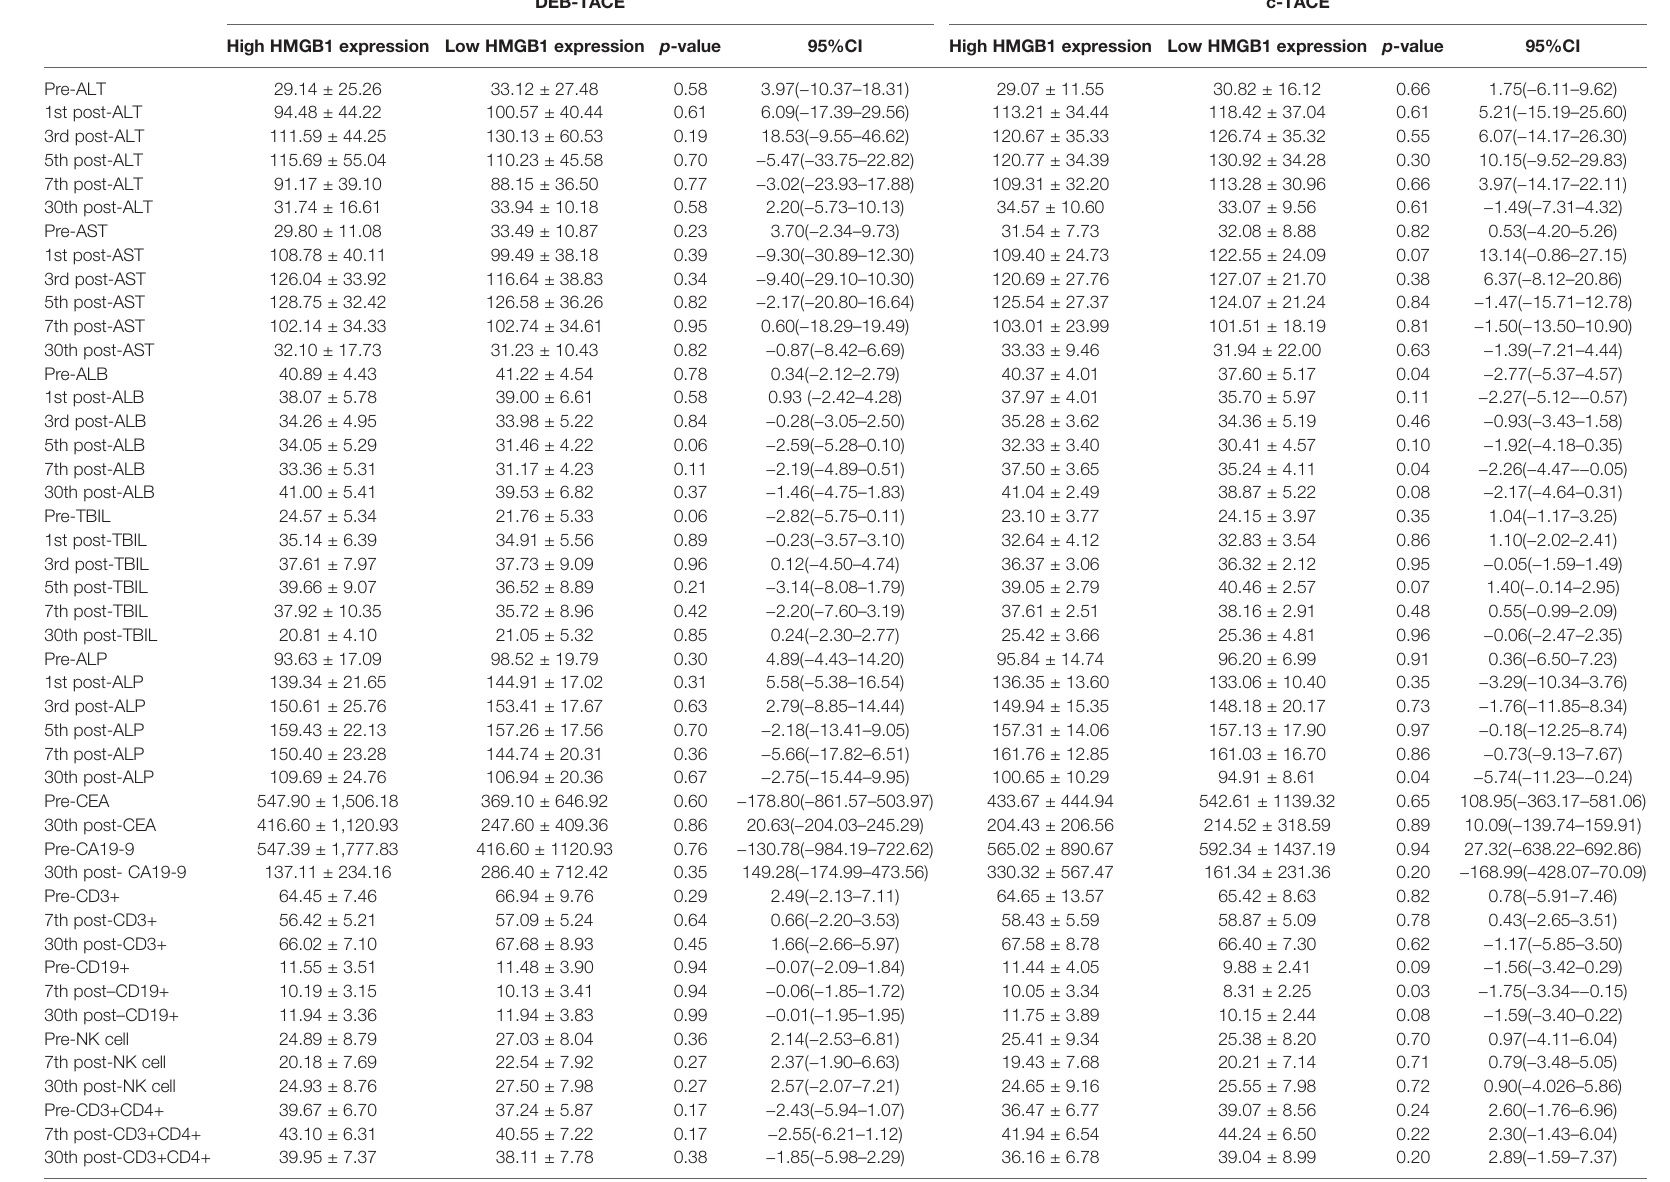
TABLE 3 | Changes of HMGB1, liver function, tumor markers and immune cells after